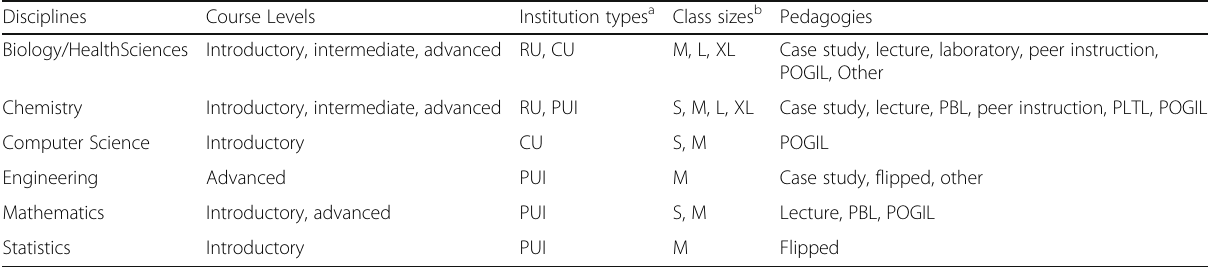
Table 1 Learning environments in which the rubrics were implemented